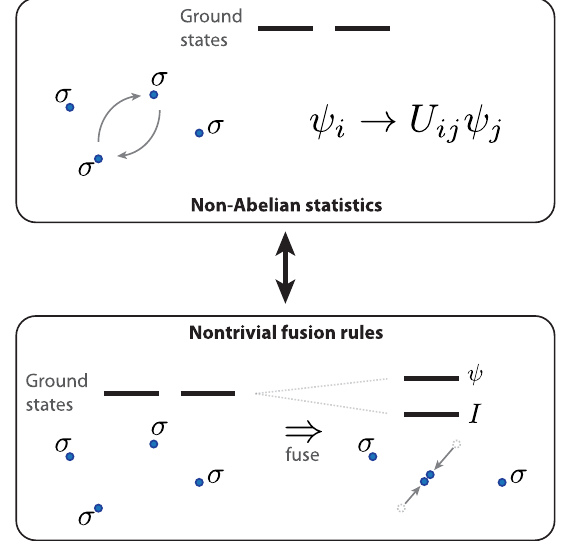
FIG. 5. Correspondence between non-Abelian statistics and nontrivial fusion rules for Ising anyons σ that obey σ × σ ¼ I þ ψ . Top: Each of the four Ising anyons shown binds a Majorana zero mode. With fixed total parity the system then admits two degenerate ground states ψ . Adiabatically braid- i ¼ 1 ; 2 → U ψ , where U denotes the ing a pair of anyons sends ψ i ij j ij braid matrix. Bottom: Alternatively fusing the pair of anyons hybridizes the associated Majorana modes and splits the twofold ground-state degeneracy. The lower and upper states correspond to the Ising anyons coalescing into the identity ð I Þ and fermion ð ψ Þ fusion channels. While fusion and braiding are intimately linked, establishing the former experimentally is expected to be much simpler; see Figs. 6 and